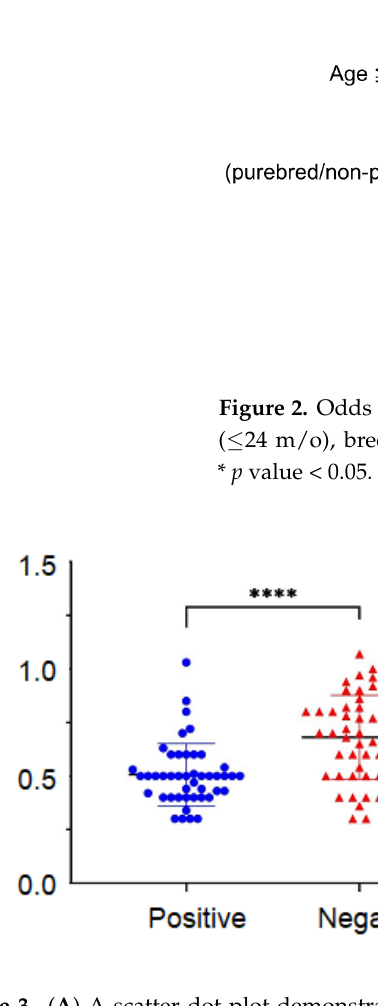
Figure 3. ( A ) A scatter dot plot demonstrating the A/G ratio of FCoV positive and negative cases. The p value was calculated based on an unpaired Student’s t -test. **** p < 0.0001. ( B ) FCoV positive and negative case distributions according to the A/G ratio.